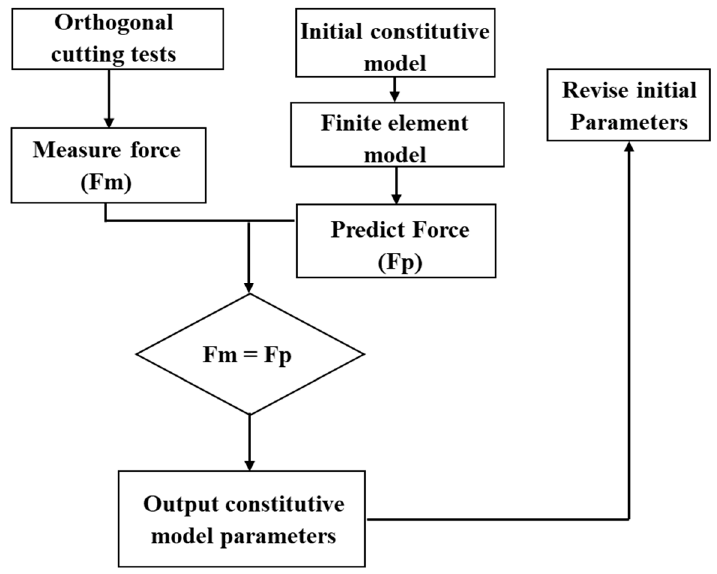
Figure 10. The inverse approach for parameter identification.